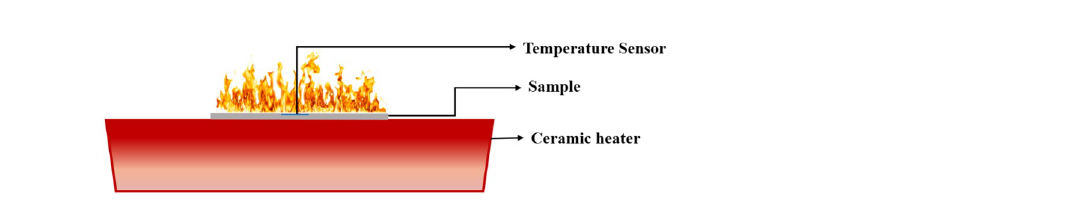
Figure 1. Scheme of experimental design analyzing the multi-scaled behaviors of contrast samples.